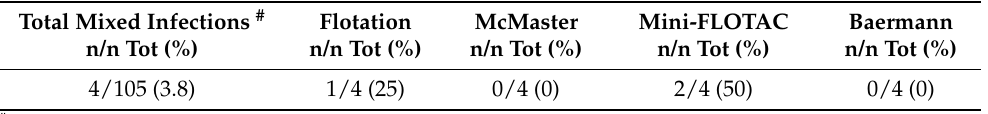
Table 9. Number of samples in which all the parasites involved in mixed infections have been